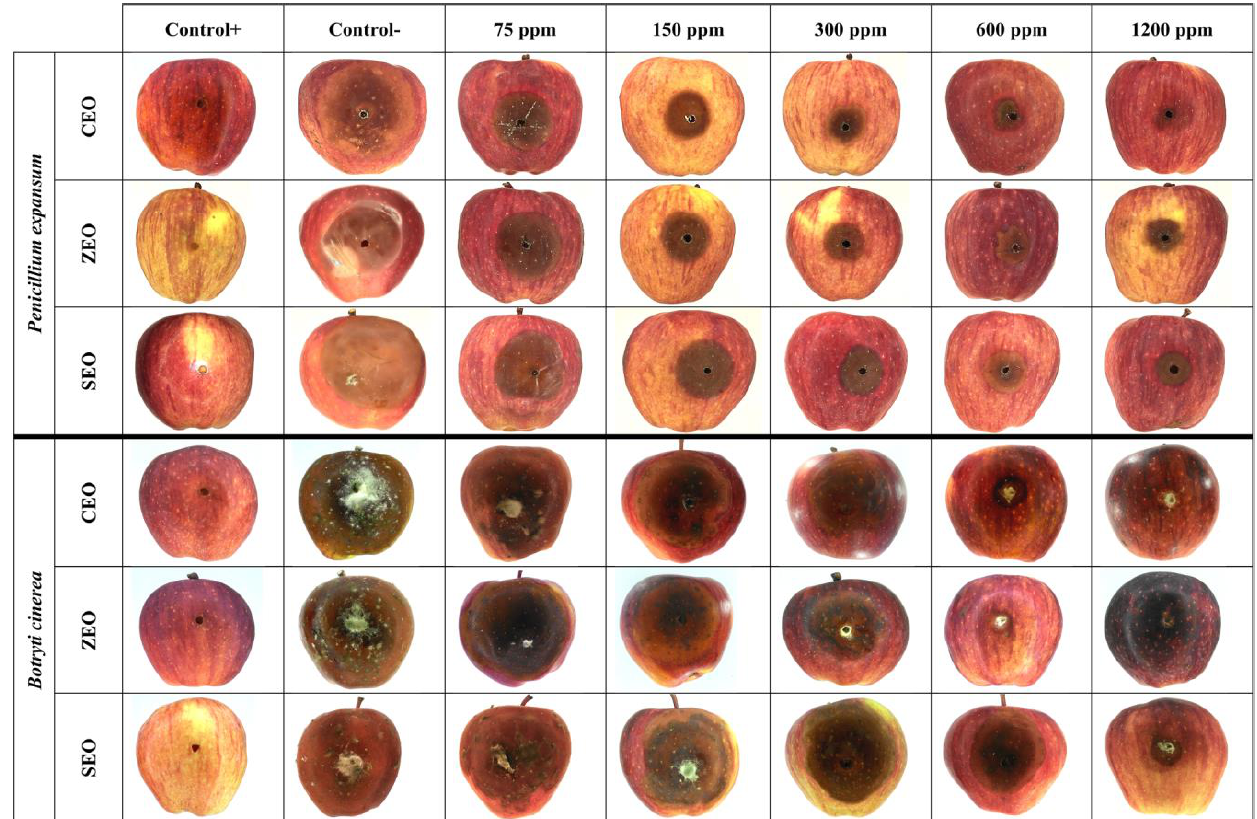
Figure 3. Digital images of apple surfaces treated with CEO, ZEO, and SEO at different concentrations (75 – 1200 μ L/L) against P. expansum and B. cinerea , artificially inoculated into fruits, after 21 days of storage at 25 °C. Images of positive and negative controls are also reported.